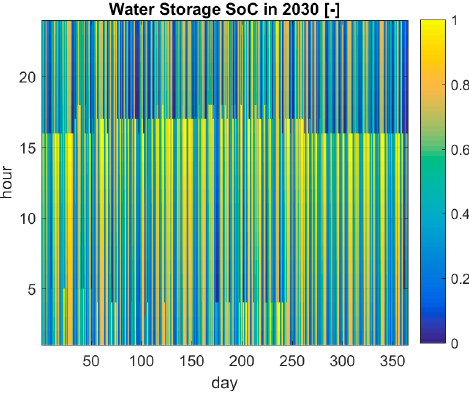
Figure 14. Water storage relative state of charge in 2030.